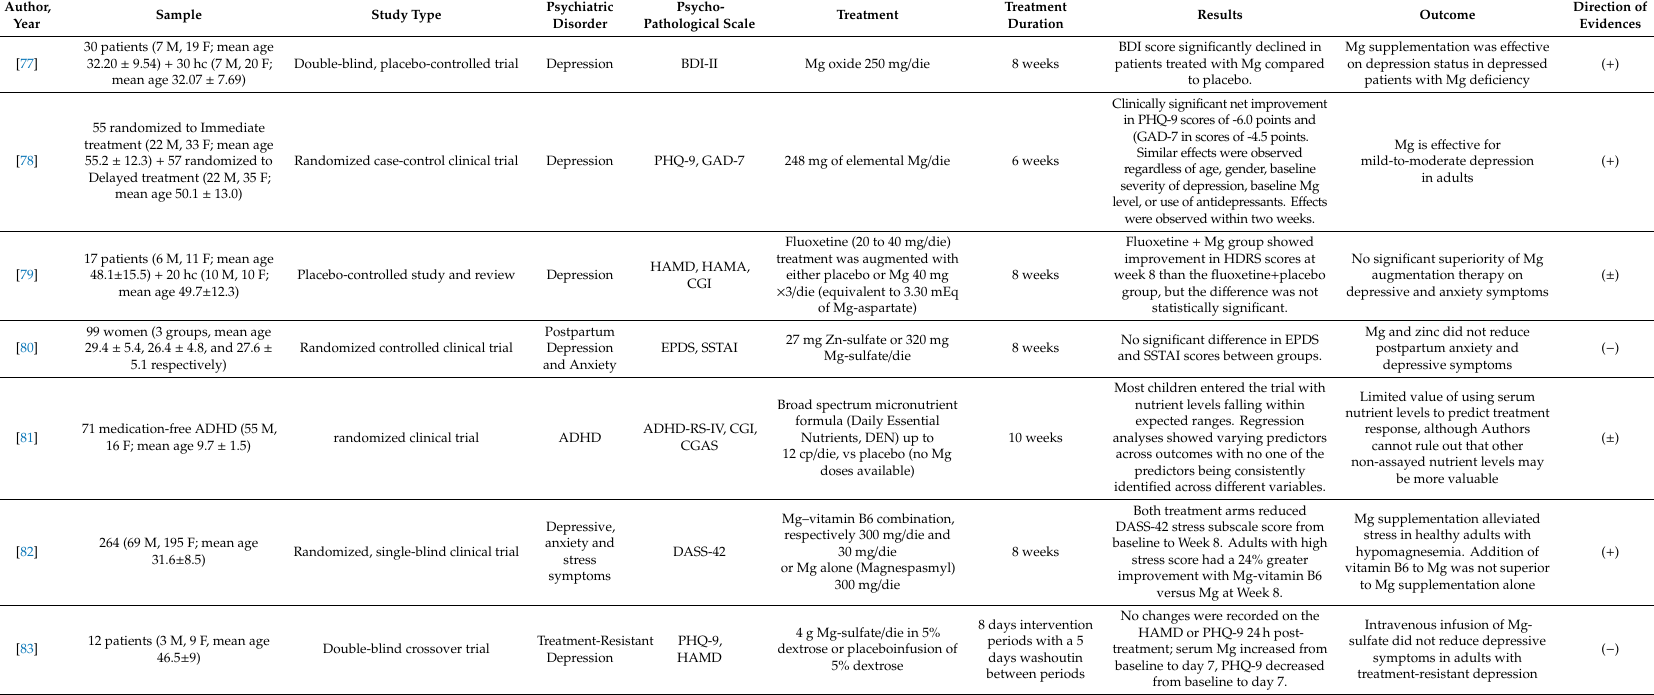
Table 2. Socio-demographic and clinical details of all included studies investigating the e ff ect of Mg as